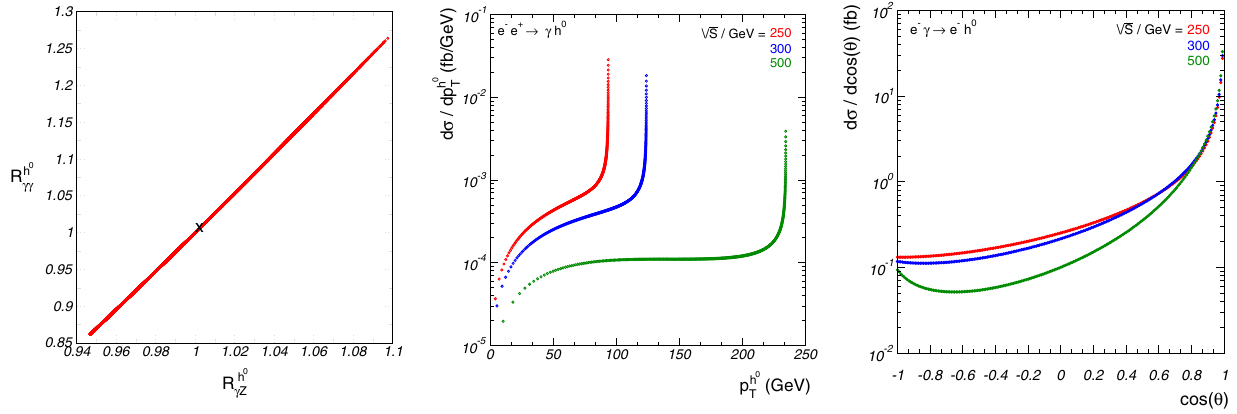
Fig. 8 Left : R h 0 γγ correlationwith R h 0 γ (resp. differential cross section for e − γ → e − h 0 ) for various Fig. 9 Differential cross section for e − e + → γ h 0 in both SM and HTM for two values of √ s = 250 GeV (left) and 500 GeV (right). We fix here (λ ,λ ) = ( − 0 . 35 , + 0 . 61 1 4